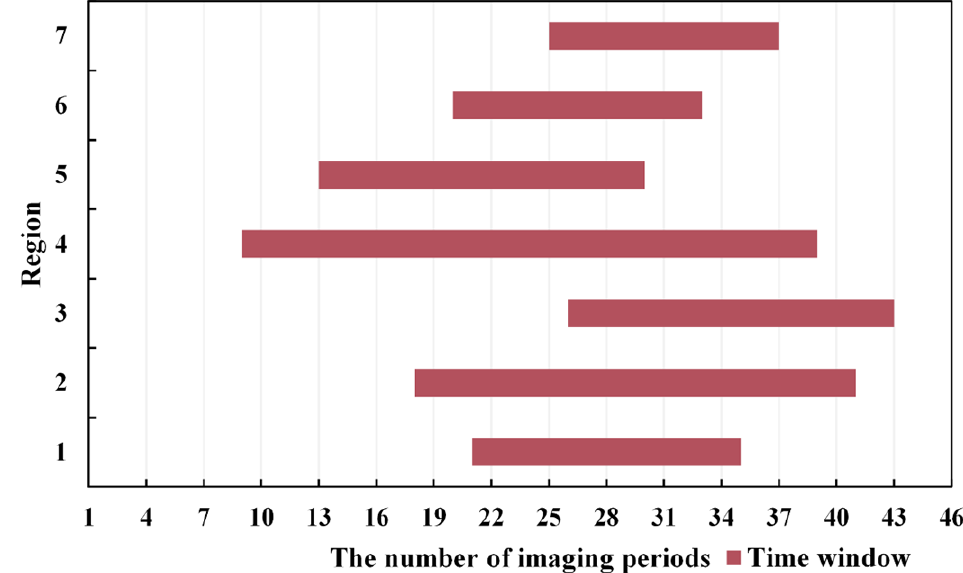
Figure 6. Time window for each region.